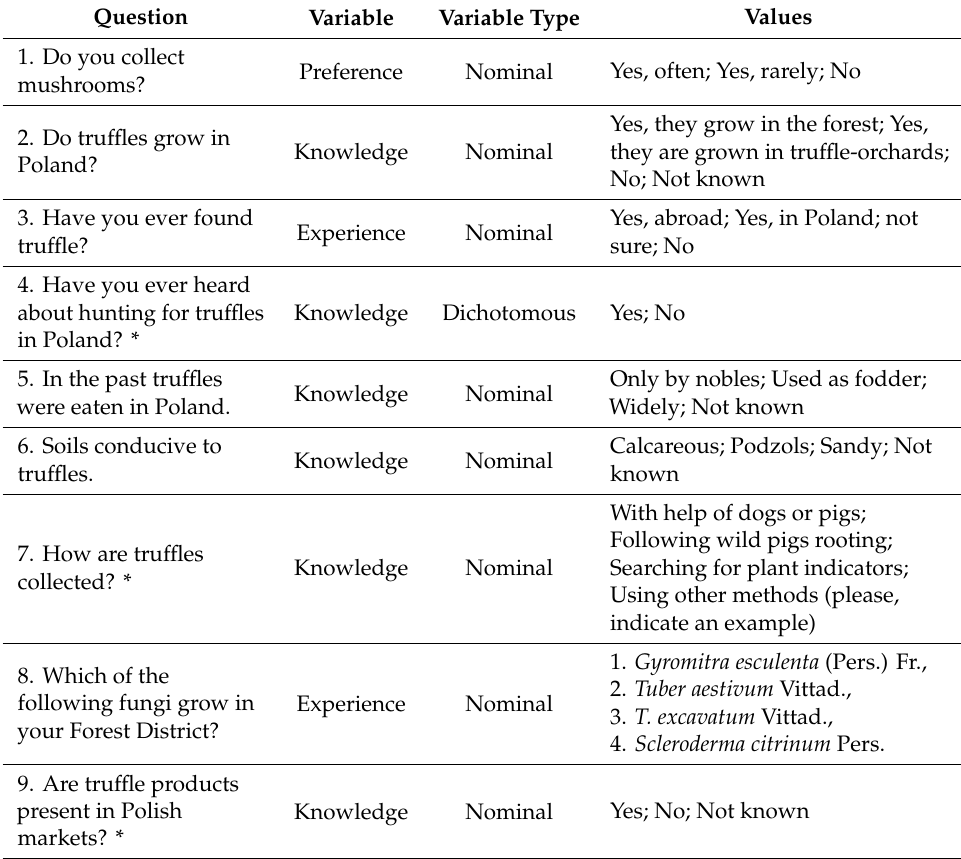
Table 3. List of dependent variables. The symbol “*” in questions 4, 7, 9 indicates that a “yes” answer allowed the respondent to provide an example and for question 7 that it was possible to give a di ff erent answer than the choices